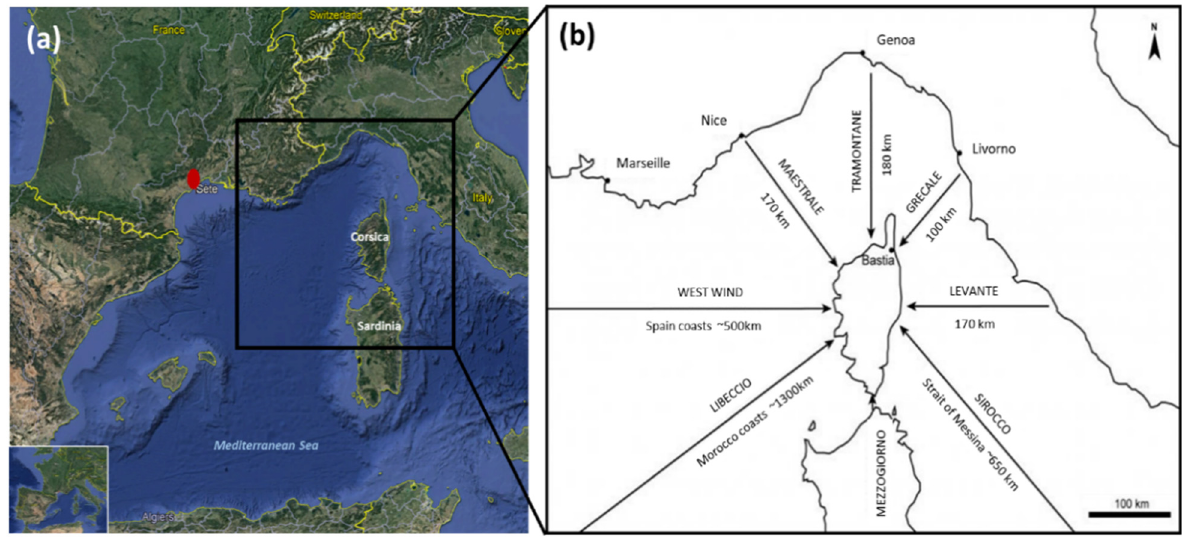
Figure 1. Location of Corsica Island and Sète (red symbol). ( a ) The map is adapted from Google Earth. ( b ) Wind provenance and crossed distance. The map is adapted from ROL Corse (Coastal Observatory Network of Corsica).